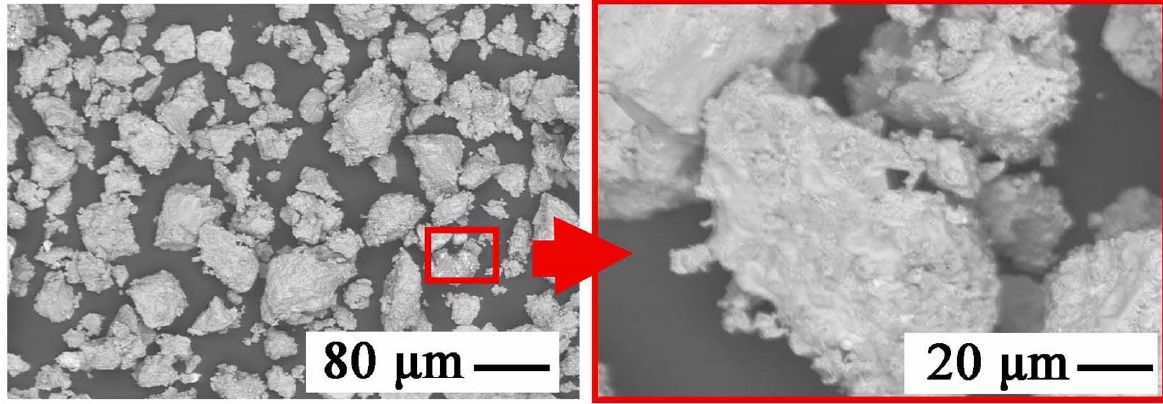
Figure 32. SEM image of the phases precipitated during selective alkalization and zinc precipitation from the electronic mass from the battery with Na 2 CO 3 participation for pH = 7.0.